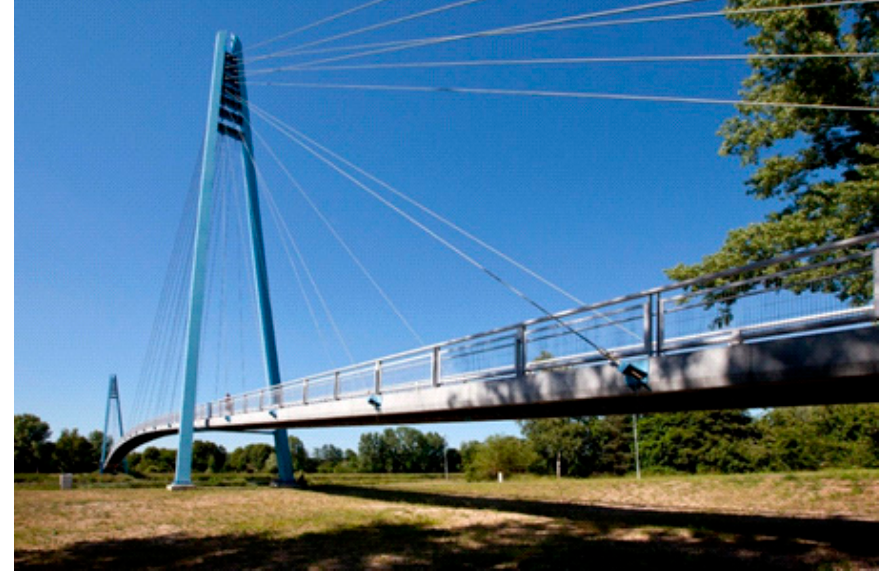
Figure 2. Footbridge from UHPC in Celakovice (2014—across the Elbe river, Czech Republic).